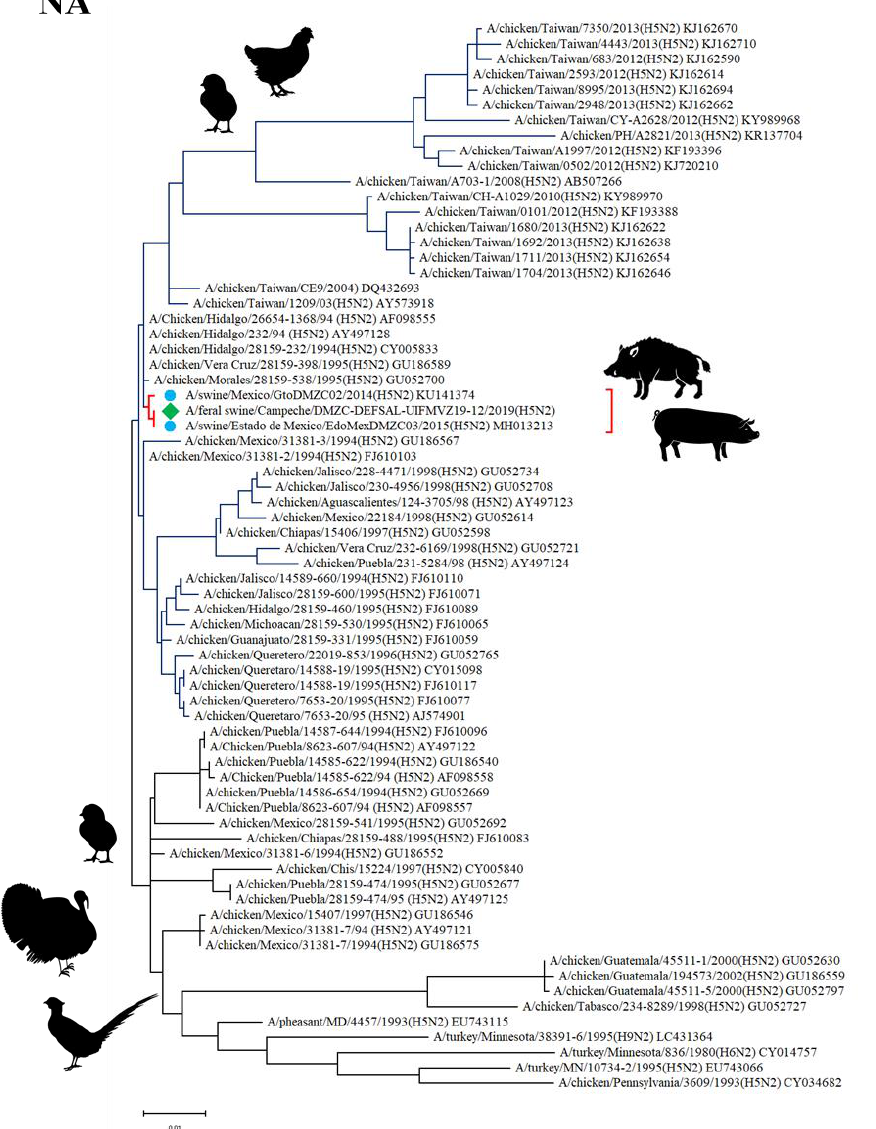
Figure 3. Phylogenetic tree of the NA gene of H5N2 influenza virus. The tree was drawn to scale, with branch length proportional to the number of substitutions per site. The H5N2 isolate herein reported is marked as 樊 , while swine H5N2 subtypes are marked as ●.